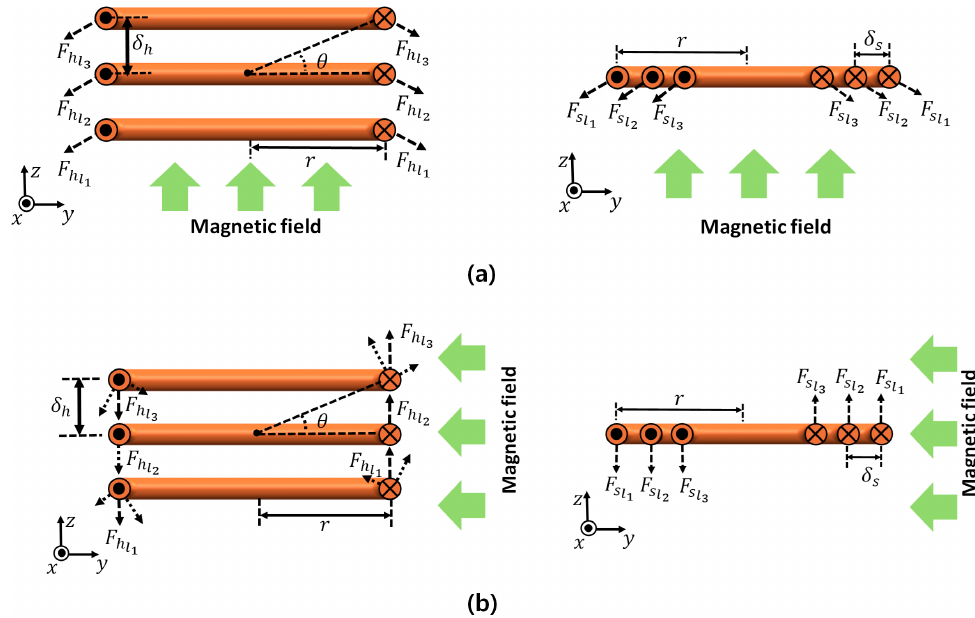
Figure 4. Generated force and torque according to an incident magnetic field vector. ( a ) When the source coil and load coil are in parallel positions, propulsion force is generated. ( b ) When the source coil and load coil are in perpendicular positions, torque is generated on the load coils. ( a ) Helical coil with pitch δ h and ( b ) spiral coil with wire gap δ s .